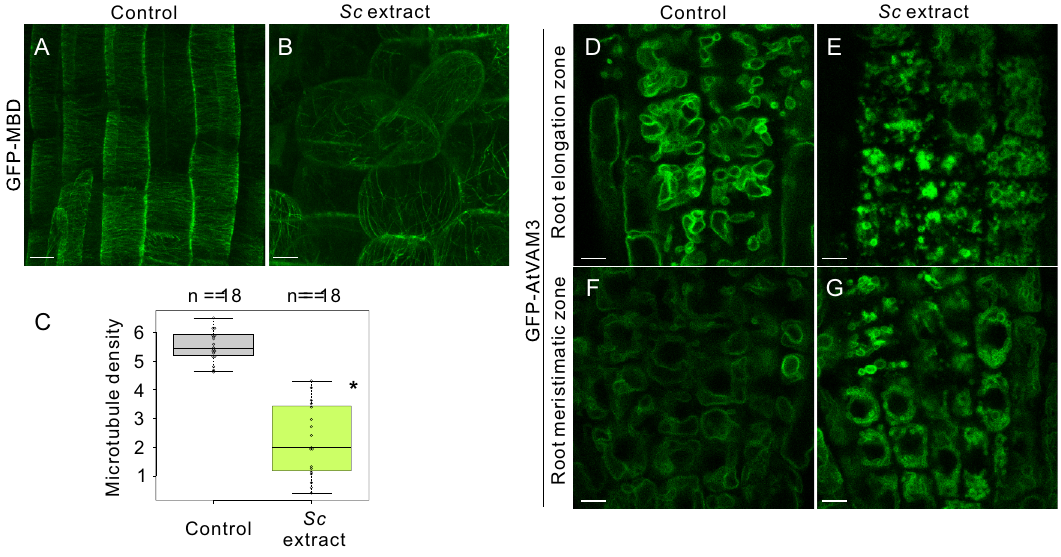
Figure 3. Changes in the structure of cortical microtubules and vacuoles in root epidermal cells after aphid extract treatment. ( A – C ) Live cell imaging of Arabidopsis root-transition zone expressing microtubule fluorescent markers GFP-MBD without ( A ) or with ( B ) S. chinensis extract treatment; (C) The density of cortical microtubules. The asterisk denotes a statistically significant difference between the control and Sc extract-treated conditions (* p < 0.05; Mann–Whitney U -test). Biological replicates of 18 seedlings. In the box-and-whisker plots, the boxes and solid lines in the boxes show the upper (75th) and lower (25th) quartiles and median values, respectively. The whiskers indicate the 95% confidence intervals. The experiments were independently repeated three times. ( D – G ) Live cell imaging of Arabidopsis root-transition zone and root division zone of transgenic Arabidopsis line expressing a vacuole membrane fluorescent marker GFP-AtVAM3 without ( D , F ) or with (E, G) S. chinensis extract treatment. Scale bars: 10 μm.